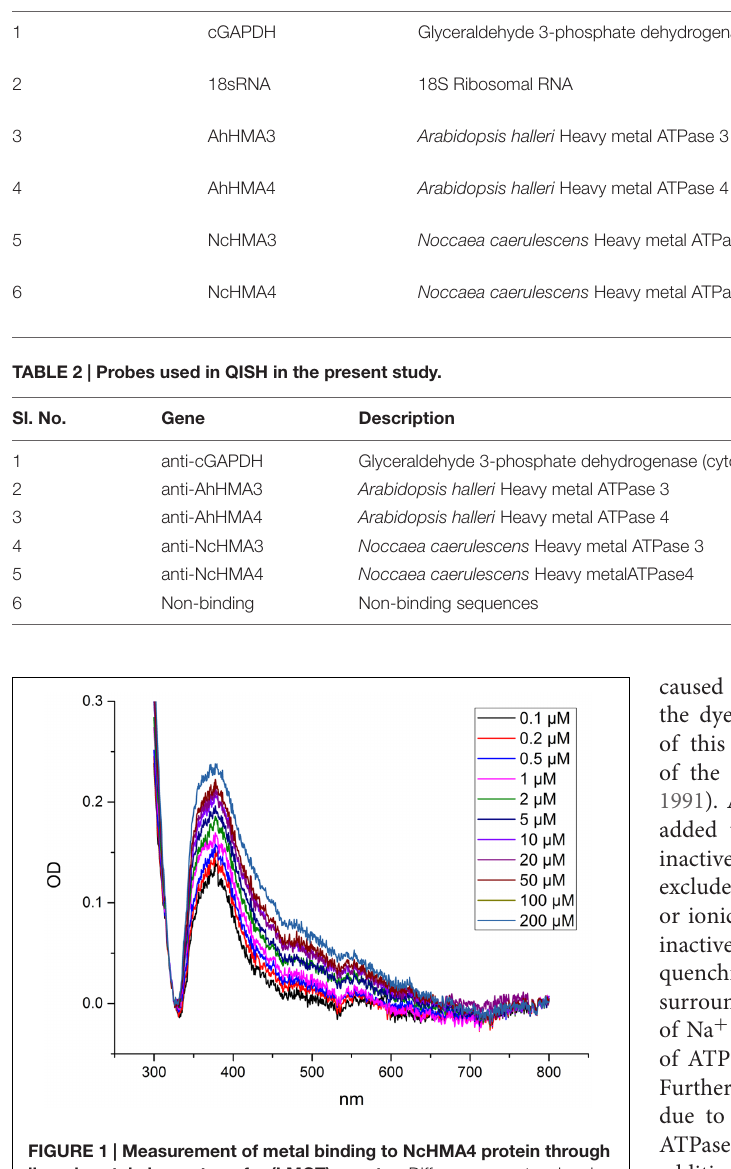
TABLE 1 | Primers used in real time quantitative RT-PCR analysis in the present study. Sl. No.